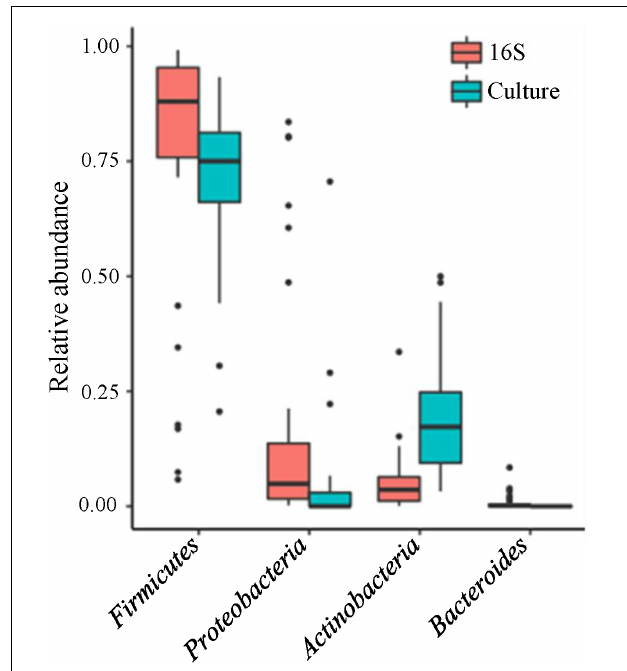
FIGURE 2 | Relative abundance of bacterial phyla in human milk samples. Boxplot presentation of relative abundances of bacterial phyla shown for 16S rRNA gene NGS approach (red) and cultivation approach (blue). Only phyla present in relative abundance > 0.1% are